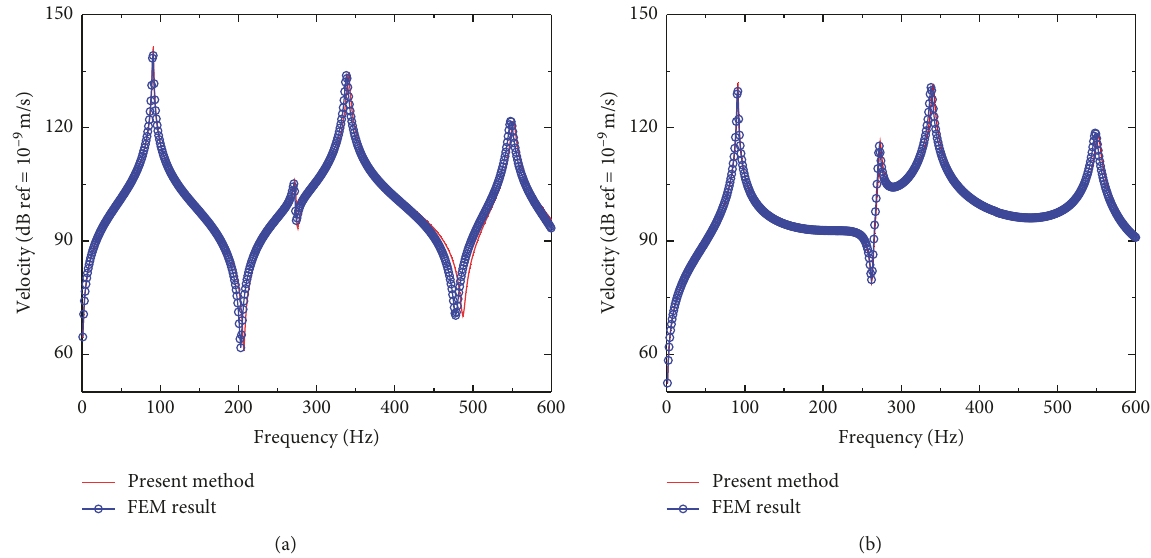
Figure 5: Comparison of velocity response for square plate with one beam located at its diagonal line under unit force ( q (0.5m, 0.5m). (b) Point D (0.25 m, 0.25m).